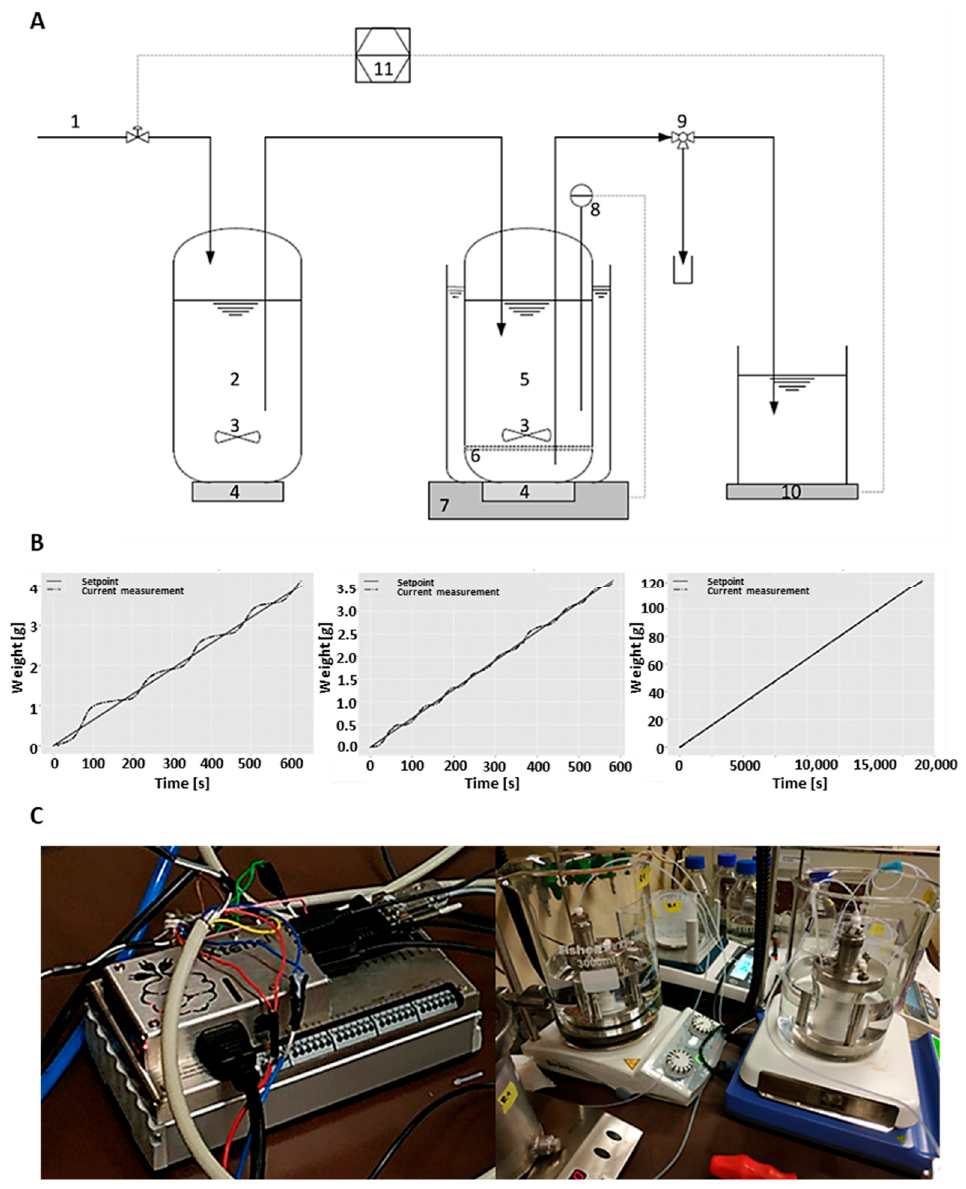
Figure 2. ( A ) Schematic representation of the experimental setup of a single enzyme membrane reactor. During the experiments, two enzyme membrane reactors were run in parallel ( C ). 1—Compressed air. 2—Substrate tank. 3—Magnetic stirrer. 4—Magnetic drives. 5—Enzyme reactor. 6—Ultrafiltration membrane. 7—Heating device. 8—Temperature sensor. 9—Sampling port. 10—Precision balance. 11—PID controller. ( B ) PID controller adjustment: screenshots of the tuning of the parameters to K P = 6, K I = 1.6, K D = 3 and correlation between the target value and measured value over time. Solid line—target value, dotted line—measured value. Tuning parameters were added subsequently from the left to the right panel. ( C ) Photo of the experimental setup of two parallel reactors during operation.